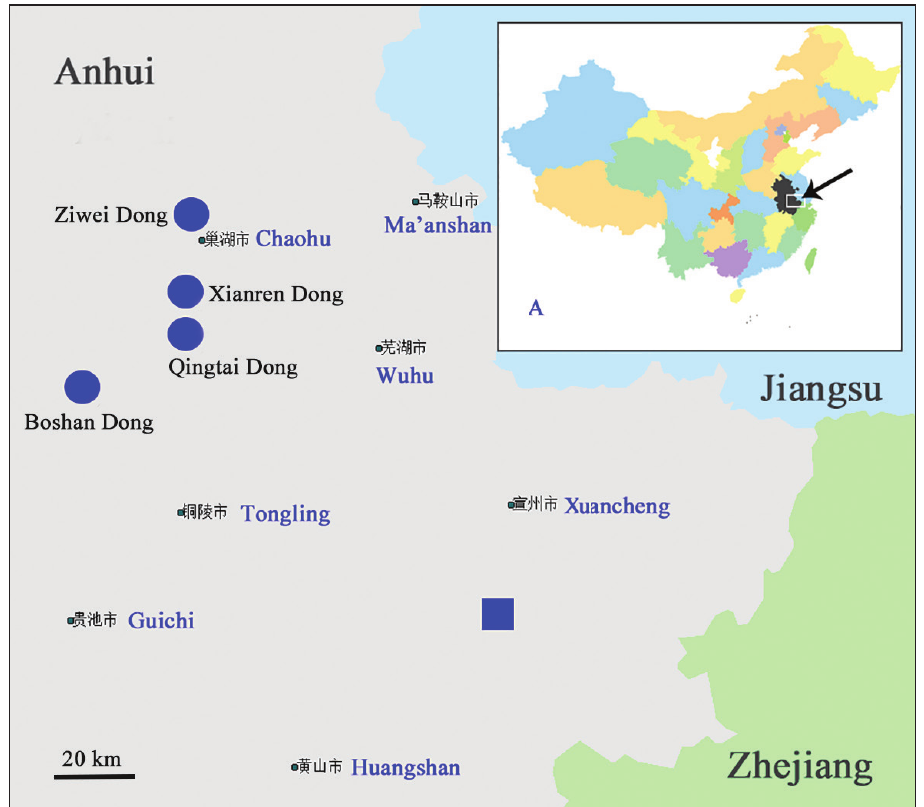
Figure 3. Distribution map of cave-dwelling trechines in Anhui Province A map of China, arrowhead showing the cave biological study area; circle localities of Cimmeritodes ( Zhecimmerites ) parvus Tian & Li, sp. n., square localities of Wanoblemus wui Tian & Fang, gen. n., sp.